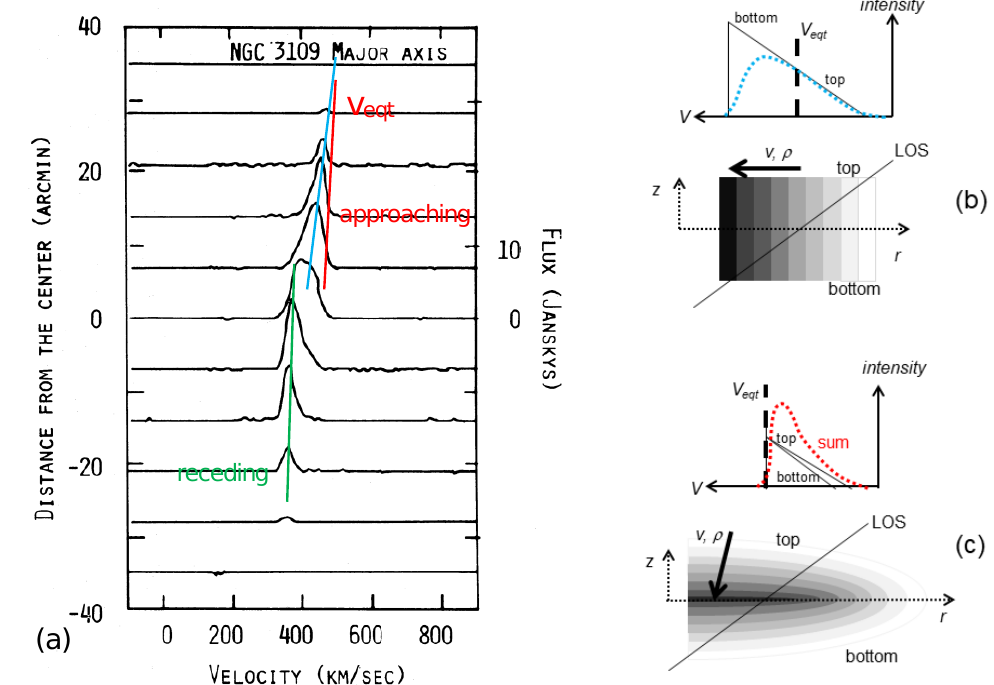
Figure5. Velocitydistributionsinaspiralgalaxy: ( a )Measuredprofile, modifiedafterC.Carignan, (1985) Light and mass distribution of the magellanic-type spiral NGC 3109, Astrophys. J. 299 , 59–73 [57], with permissions by the AAS. In this panel only , velocity increases to the right . Blue line shows the expected equatorial velocity for a disk. Red and green lines = the expected equatorial velocity for an oblate; ( b ) Schematic constructing the expected profile (upper section) for a thin disk consisting of rotating rings, where the lower section shows a vertical slice through the galaxy indicating the systematic changes in density and velocity with equatorial radius and a line of sight (LOS). Light lines show the flux-velocity correlations inside the disk, where the colored curve estimates attenuation of the emitted flux along the LOS. For a ring-disk geometry, the equatorial velocity would be midway between the minimum and maximum velocities; ( c ) Schematic constructing the expected profile (upper section) for an oblate shape consisting of rotating homeoids (lower section). The top and bottom velocity-flux correlations are identical, but are o ff set for clarity. These will sum, but emissions from the bottom are attenuated more. The red curve approximates the attenuated sum. The equatorial velocity would be the maximum observed, if resolution is very high, but more likely a small tail will exist, representing beam